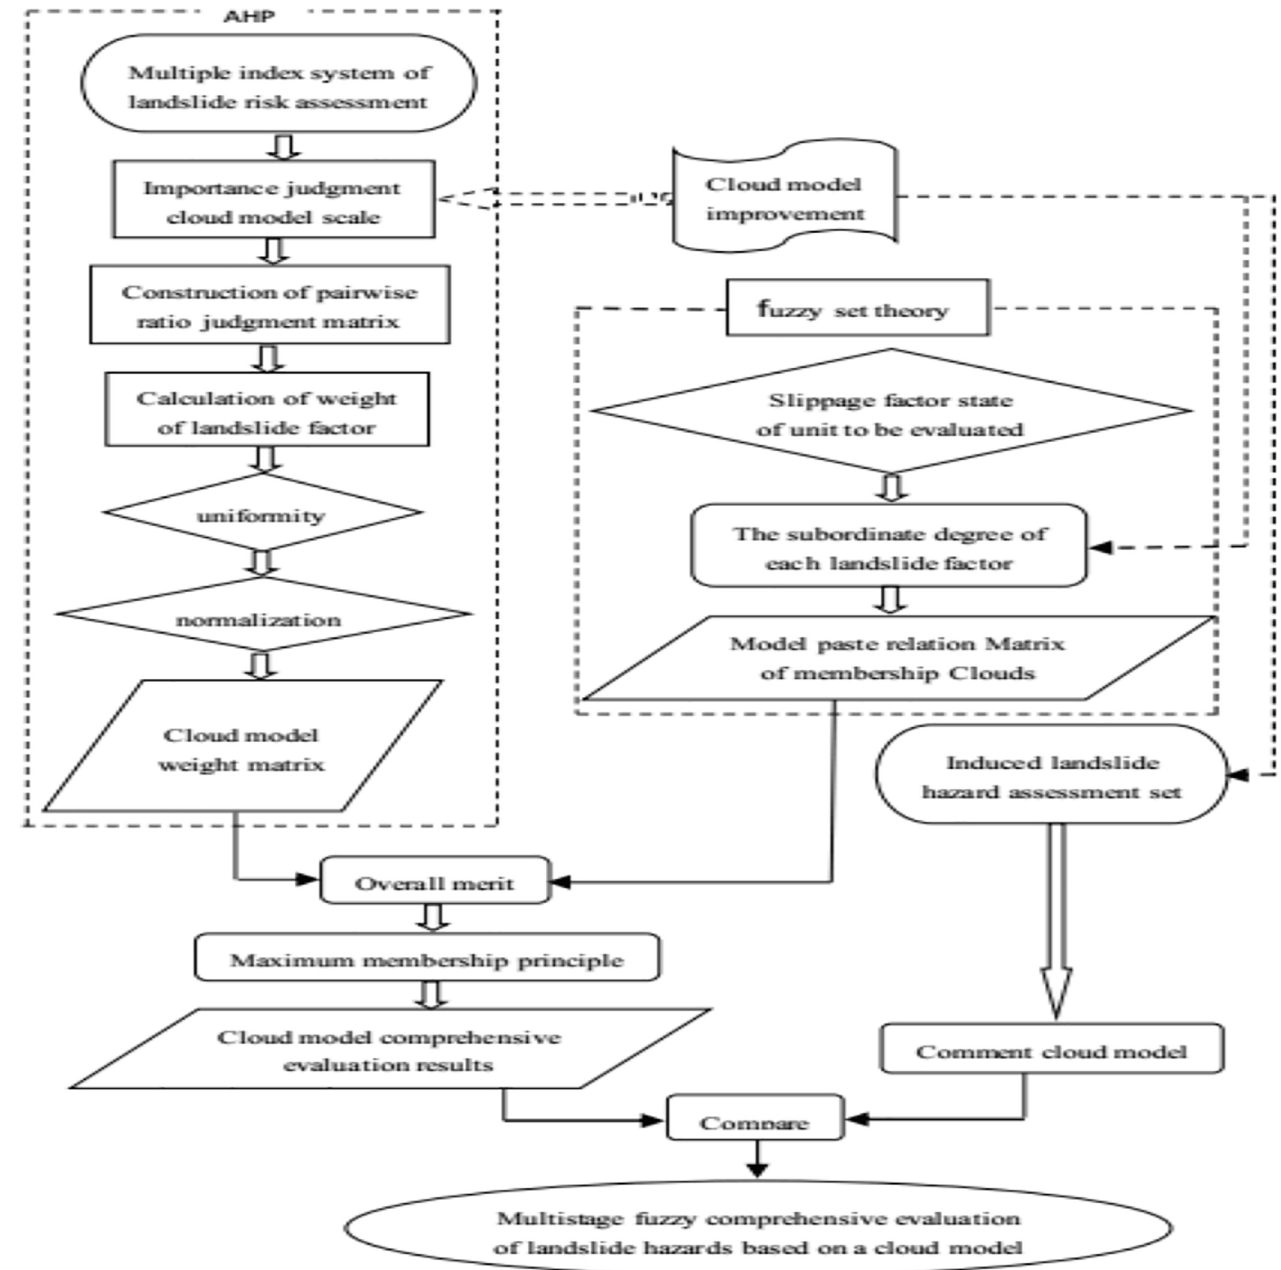
Fig 2. Flowchart of the improved multistage fuzzy evaluation model for landslide hazards based on a cloud model.